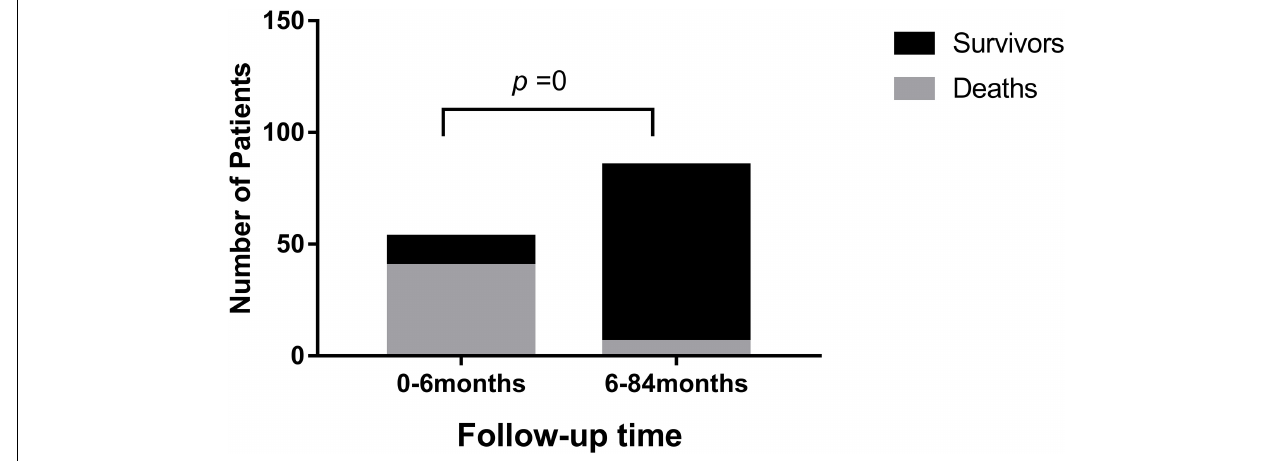
FIGURE 2 | The comparison of mortality according the follow-up time after diagnosis of DCM.